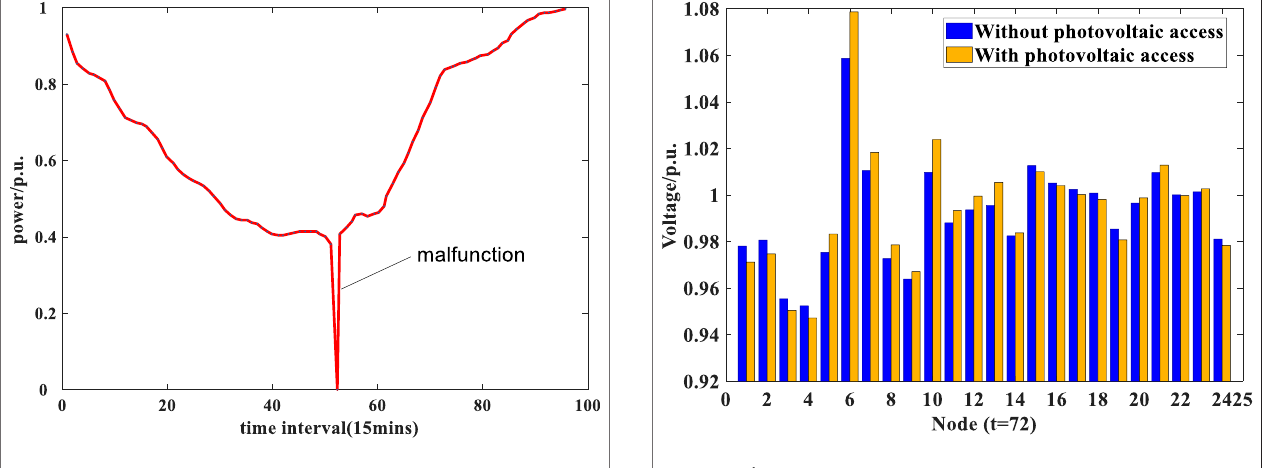
FIGURE 3 | A particular daily pro fi le of the normalized power transfer (p.u.) across UHV transmission lines.